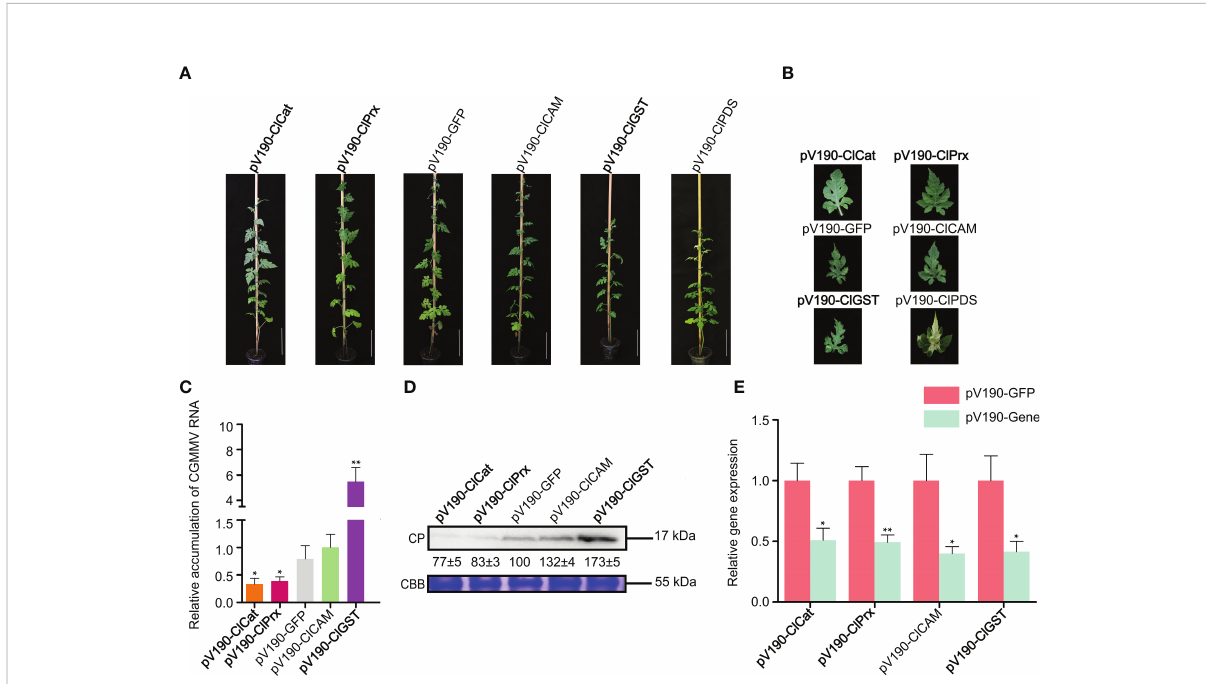
FIGURE 8 Functional analyses of four ROS-related genes through CGMMV-based VIGS assays in watermelon. (A) Disease symptoms on different gene- silenced watermelon plants after CGMMV infection. (B) Close-up views of the upper fourth leaves in watermelon. (C) CGMMV accumulations determined by RT-qPCR in different gene-silenced watermelon plants. Asterisks indicate statistical difference between treatments, determined by the two-tailed t test (* P < 0.05, ** P < 0.01). (D) The expression levels of CGMMV CP proteins in the upper fourth leaves of watermelon. (E) Silencing ef fi ciencies of target genes determined through RT-qPCR. Asterisks indicate statistical difference between treatments, determined by the two-tailed t test (* P < 0.05, ** P <